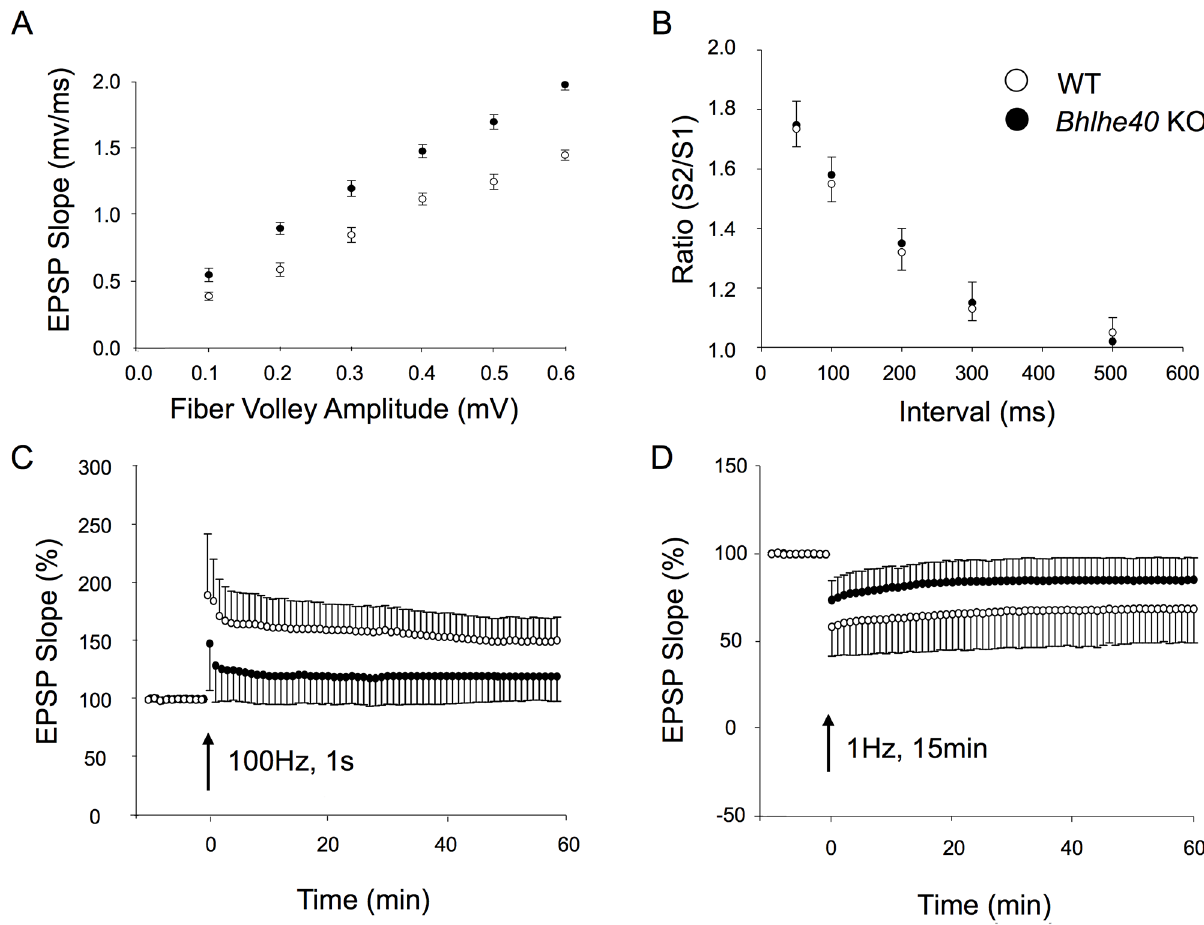
Fig 3. Bhlhe40 KO mice have reduced hippocampal synaptic plasticity. (A) EPSP slope input/output curves were significantly different (p < 0.001; n = 9). (B) Paired pulse facilitation is not significantly impaired (p = 0.063; n = 5). (C) There was a 60% reduction in LTP measured by EPSP slope 1hr following 1s of 100Hz stimulation ( Bhlhe40 KO: 120 ± 20.7%, WT: 150.5 ± 21%; p < 0.001; n = 5 mice, 6 slices each). (D) There was a 52% reduction in LTD measured by EPSP slope 1hr following 15min of 1Hz stimulation ( Bhlhe40 KO: 85 ± 12.8%, WT: 68.5 ± 19.5%; p < 0.001; n = 5 mice, 6 slices each). Data from Figs 3A, 3B, 3C, and 3D were p < 0.05 on Shapiro Wilk normality test and tested for significance by Mann-Whitney Rank Sum Test. Error bars are standard error of the mean.